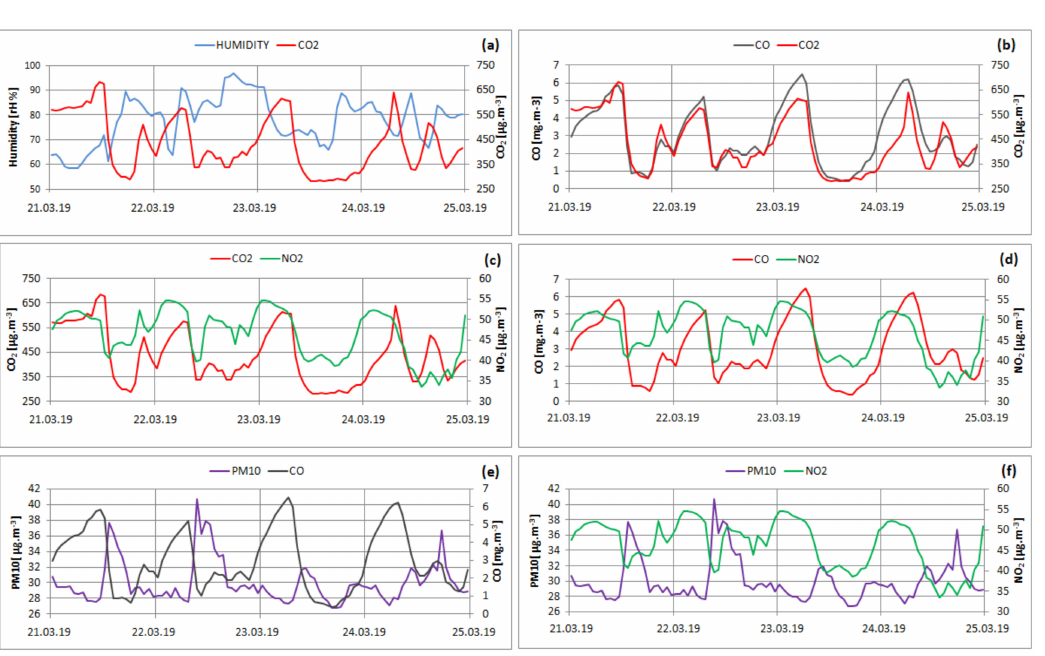
Figure 4. Relationship between gases during four-day measurement, ( a ) Humidity- CO 2 , ( b ) CO-CO 2 , ( c ) CO 2 - NO 2 , ( d ) CO-NO 2 , ( e ) PM 10 -CO, ( f ) CO-NO 2